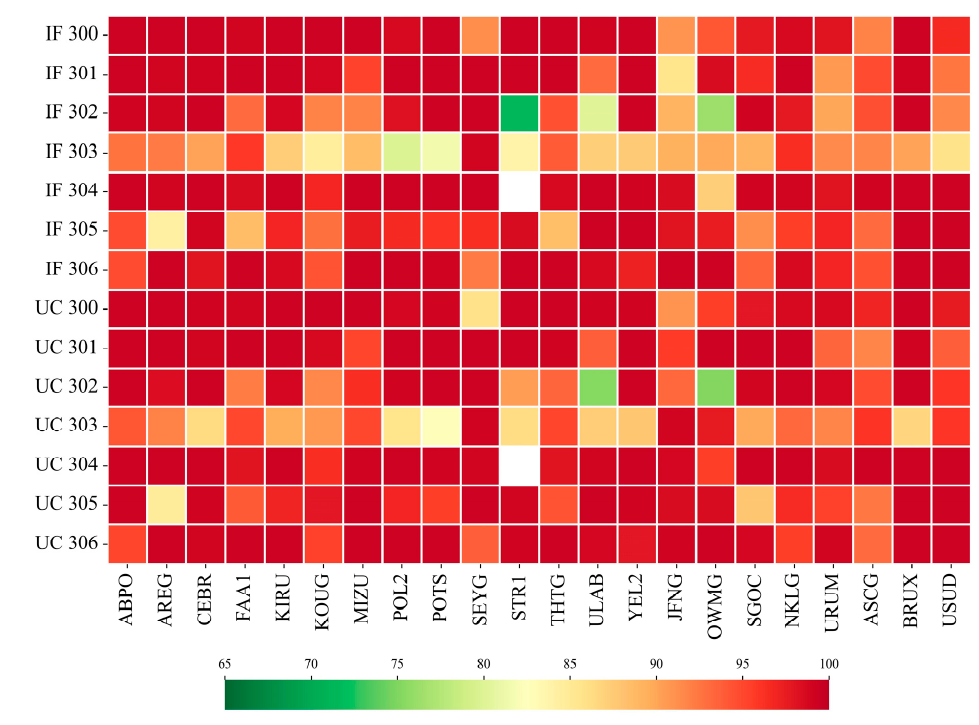
on DOY 300–306, 2021, for 22 stations.